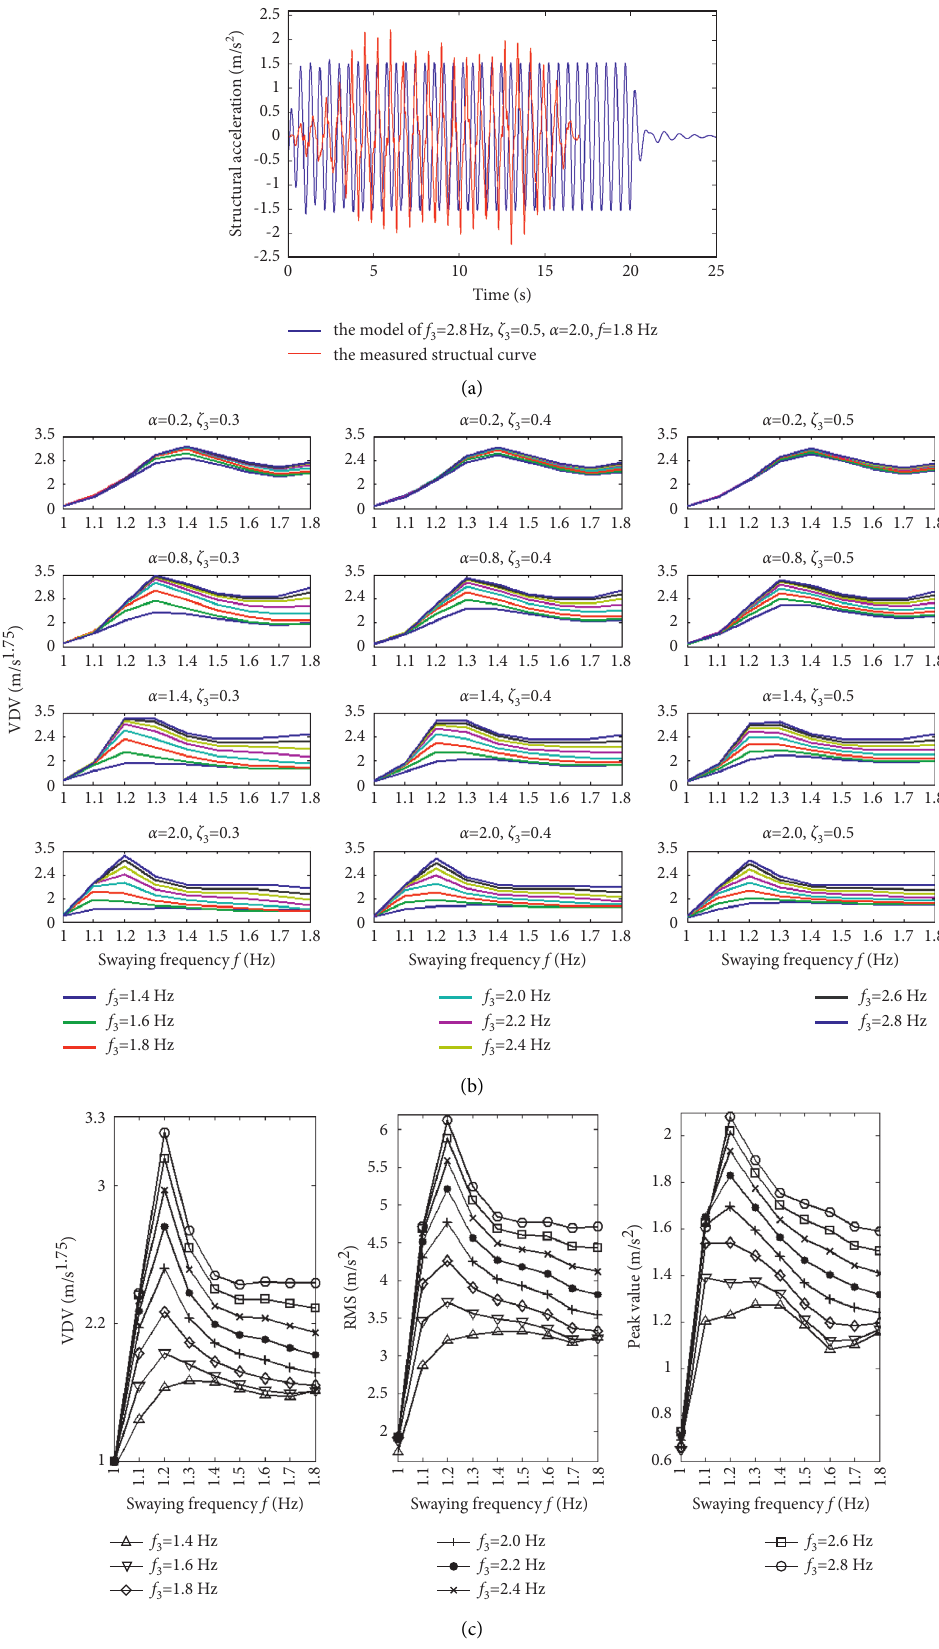
Figure 18: The structural dynamic responses of models with different passive crowd parameters. (a) The structural acceleration curve of one model at swaying load; (b) the structural acceleration VDV of models; (c) the acceleration VDV, RMS and peak values with swaying